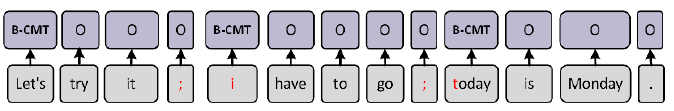
Figure 11. Ablation study on incorrect scene detection.